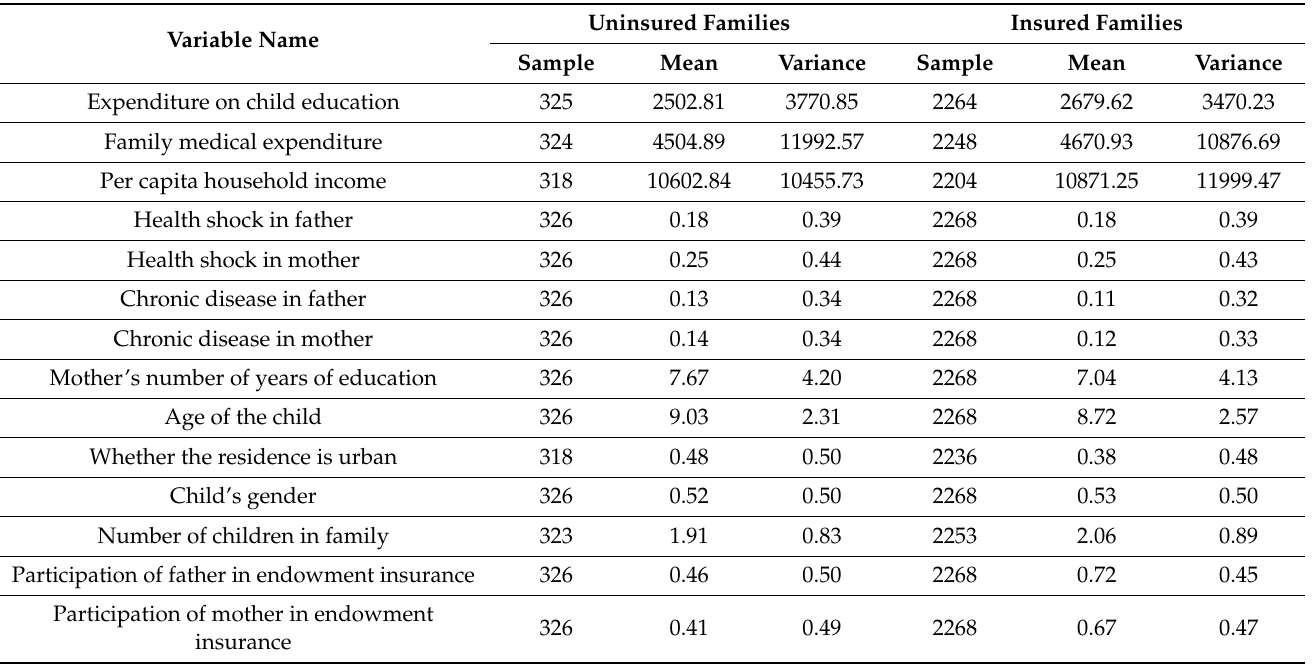
Table 2. Descriptive statistics of variables (Table 2 is only a simple statistical description of the data, which tends to show the overall differences between the insured families and the uninsured families. Our empirical tests are based on all families, not separately on insured families and uninsured families).